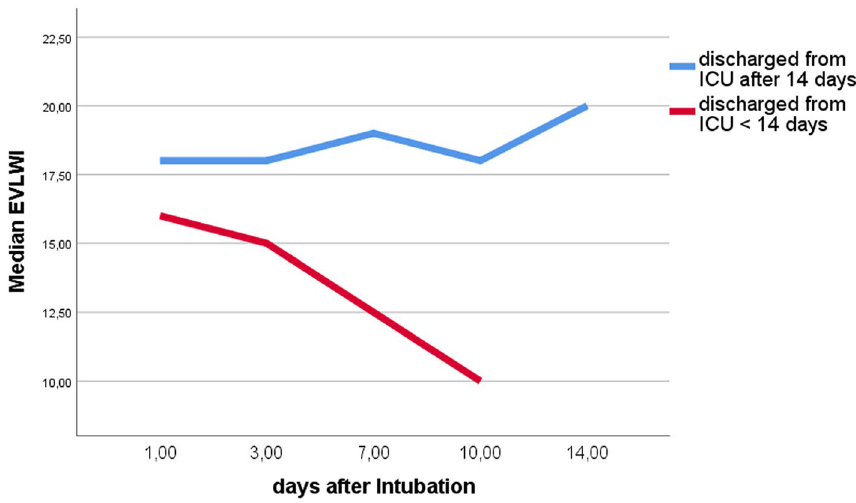
Figure 2. Extra vascular lung water index (EVLWI) of patients with COVID-19 who required less and more than 14 days of treatment on intensive care unit